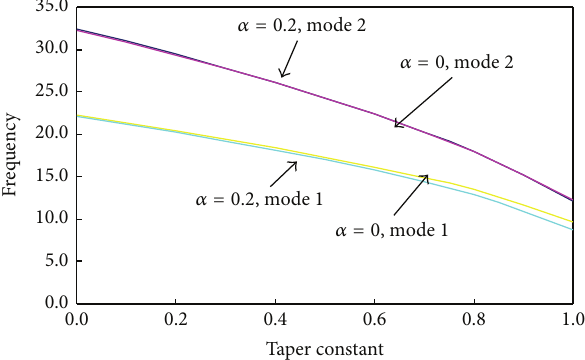
Figure 7: Value of frequency parameter for orthotropic trapezoidal plates for different values of thermal gradient and fixed values for 𝑎/𝑏 = 1.0 , 𝑐/𝑏 = 0.5 .